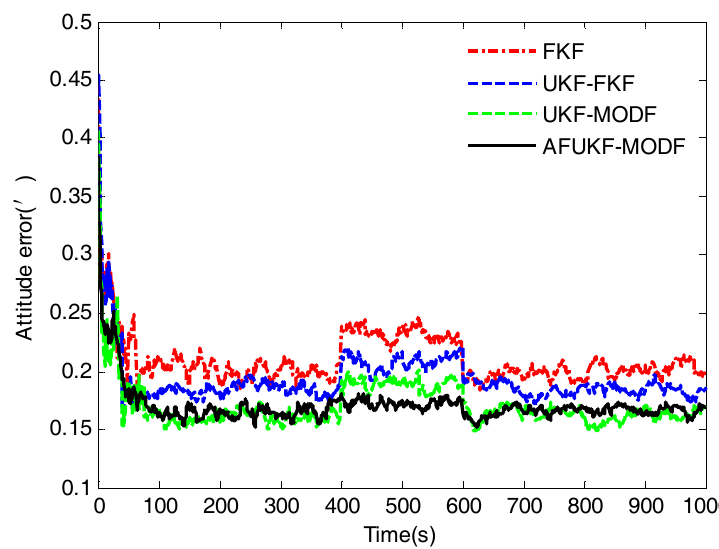
Figure 3. The RMSEs of overall attitude errors obtained by FKF, UKF-FKF, UKF-MODF and AFUKF-MODF for the simulation case. Sensors 2018 , 18 , x FOR PEER REVIEW